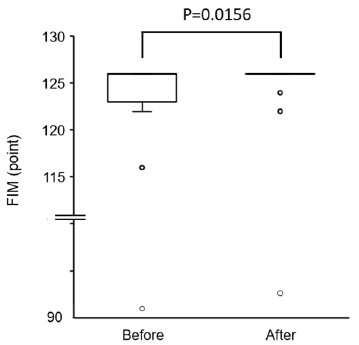
Figure 3. Changes in functional independence measure (FIM) score after physical therapy.